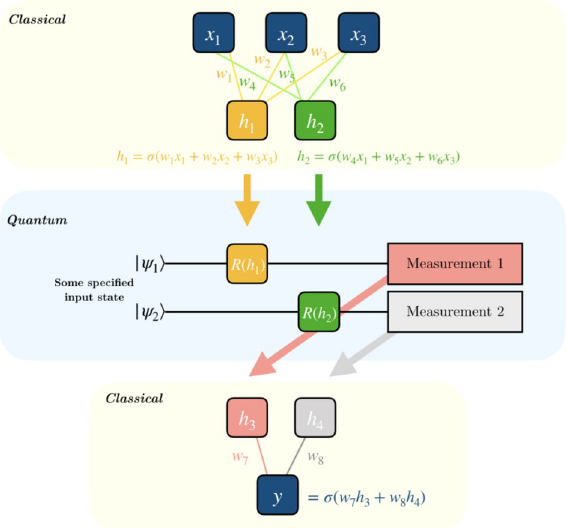
Figure 7. Quantum circuit implementing hybrid classical–quantum classifier, each block corresponds to the layer of classical neural network. Taken from the online source Ref. 57